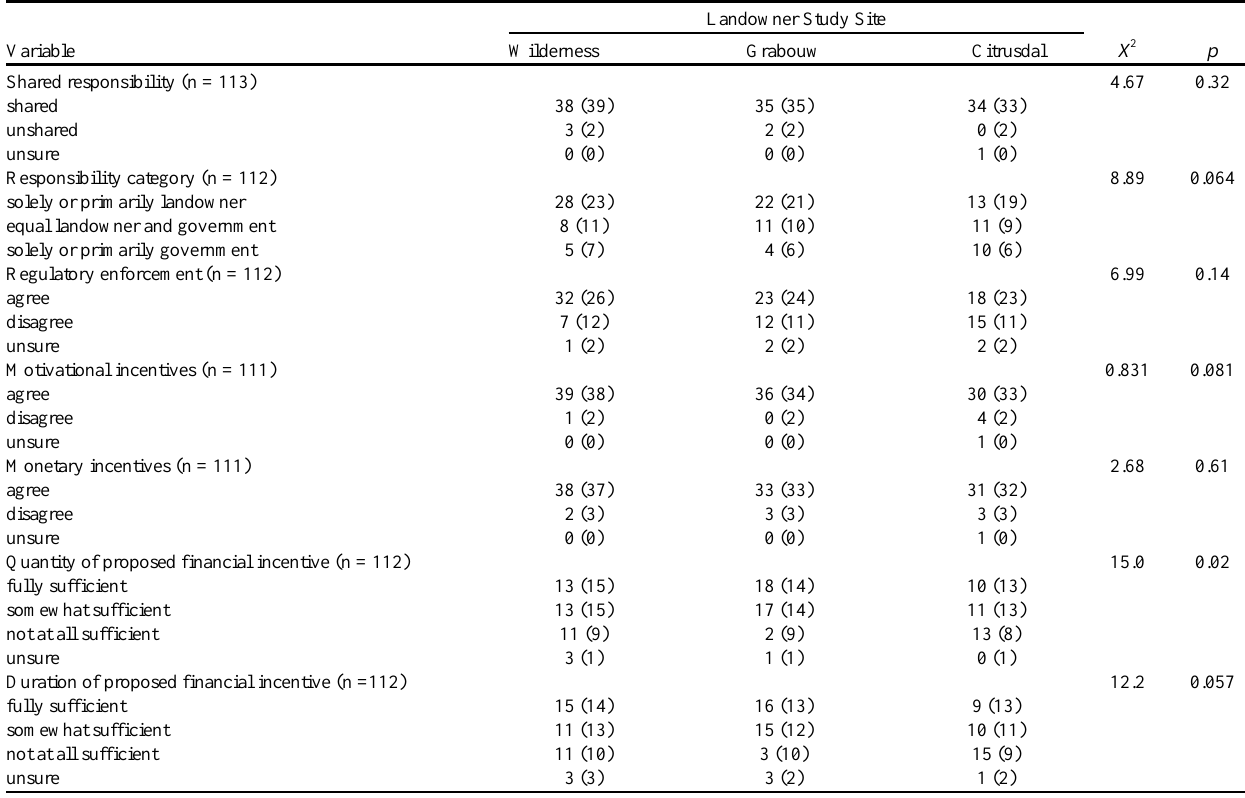
Table 5 . Relationships between landowner study site and participant responses to closed-ended questionnaire items regarding the principles and structure of WfW’s proposed ecosystem service approach to clearing IAPs on private land, Western Cape. Values are the frequency observed (expected) based on chi-square